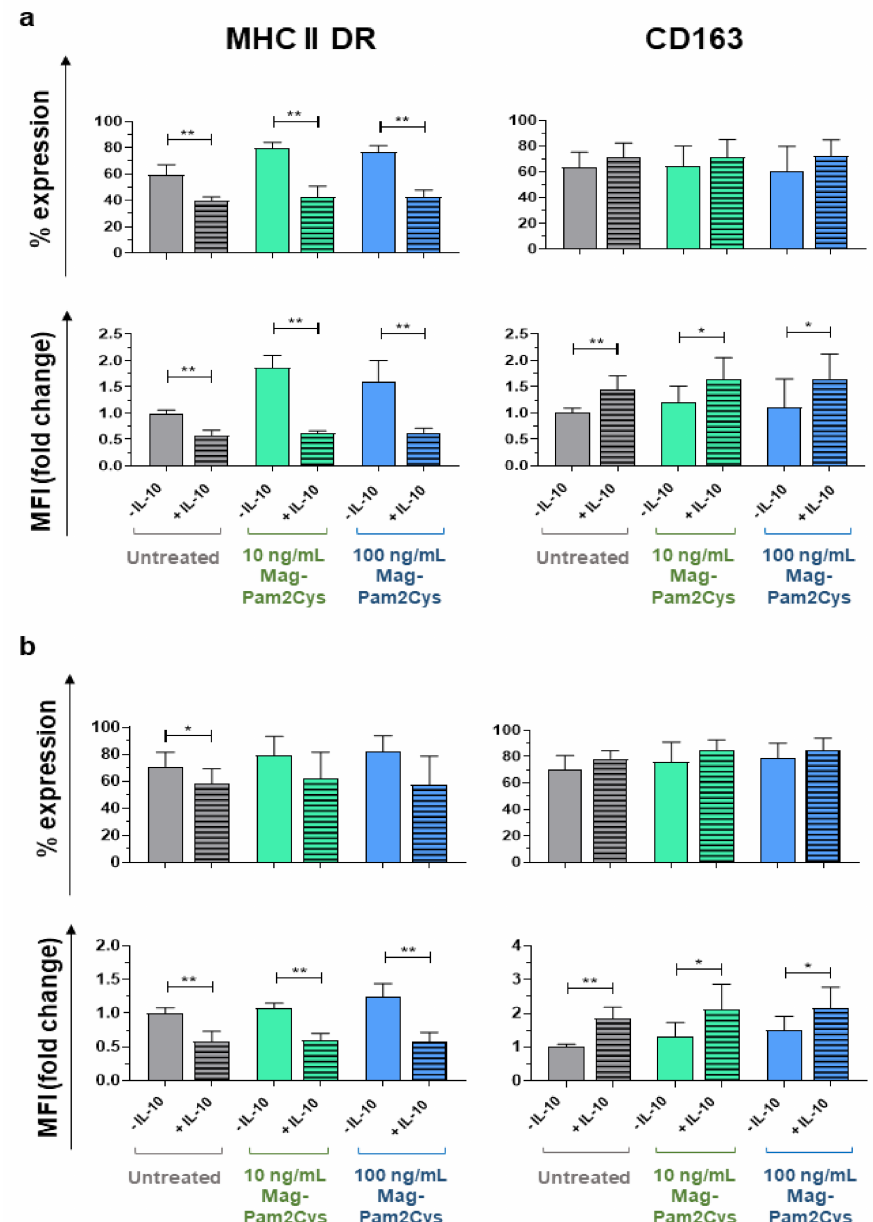
Figure 10. Mag-Pam2Cys modulation of moM Φ response to IL-10 stimulation. Porcine moM Φ were left untreated or stimulated with scalar doses of Mag-Pam2Cys (10 or 100 ng/mL). Simultaneously ( a ) or 24 h later ( b ) recombinant porcine IL-10 (20 ng/mL) was added to well. Surface expression of MHC II DR and CD163 were evaluated by flow cytometry. Percentages of positive cells and mean fluorescence intensity (MFI) data (presented as fold-change relative to the untreated condition, moM Φ ) are displayed in both panels. For both Panels ( a , b ), mean data and SD from three independent experiments using different blood donor pigs are presented. Values of stimulated samples were compared to the corresponding untreated control (moM Φ ) using a one-way ANOVA followed by a Dunnett’s multiple comparison test. ** p < 0.01, * p <